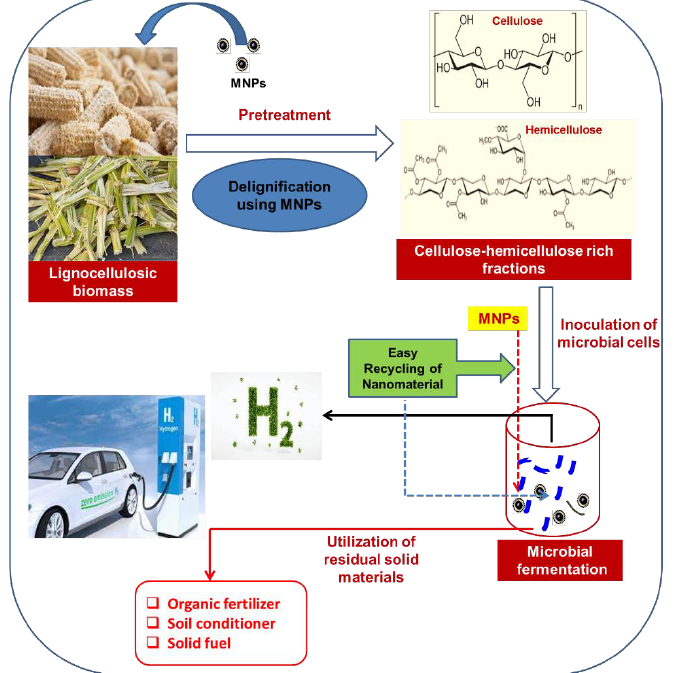
Figure 3. Application of nanotechnology approach for pretreatment and hydrolysis of LCB substrates and its conversion into biohydrogen.